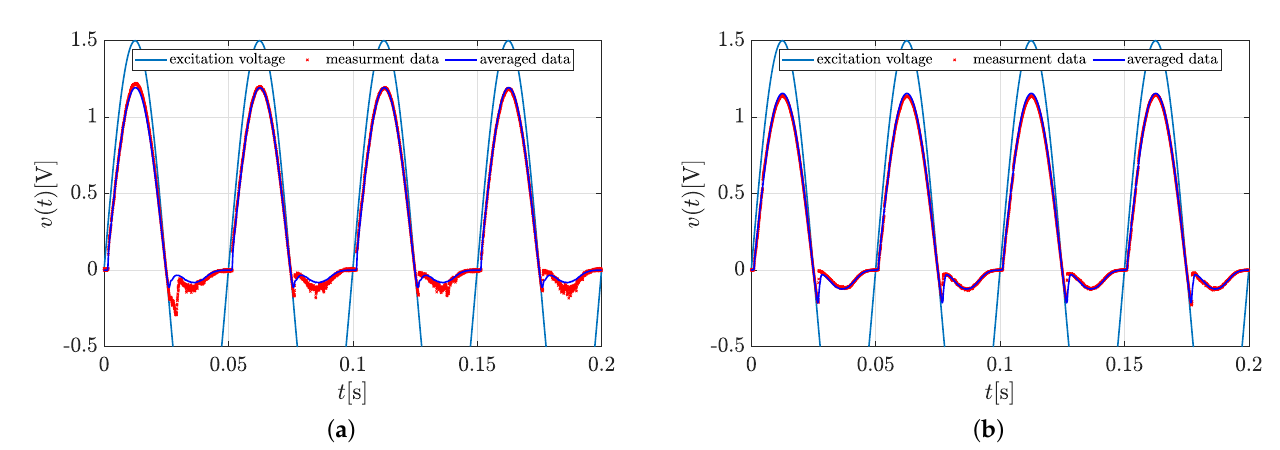
Figure 3. Acquired time signals for the for the first 4 periods corresponding to the plots presented in Figure 2. ( a ) Tungsten dopant; ( b ) Carbon